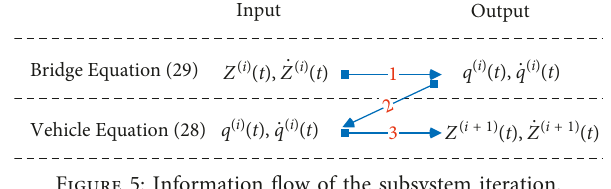
Figure 5: Information flow of the subsystem iteration.